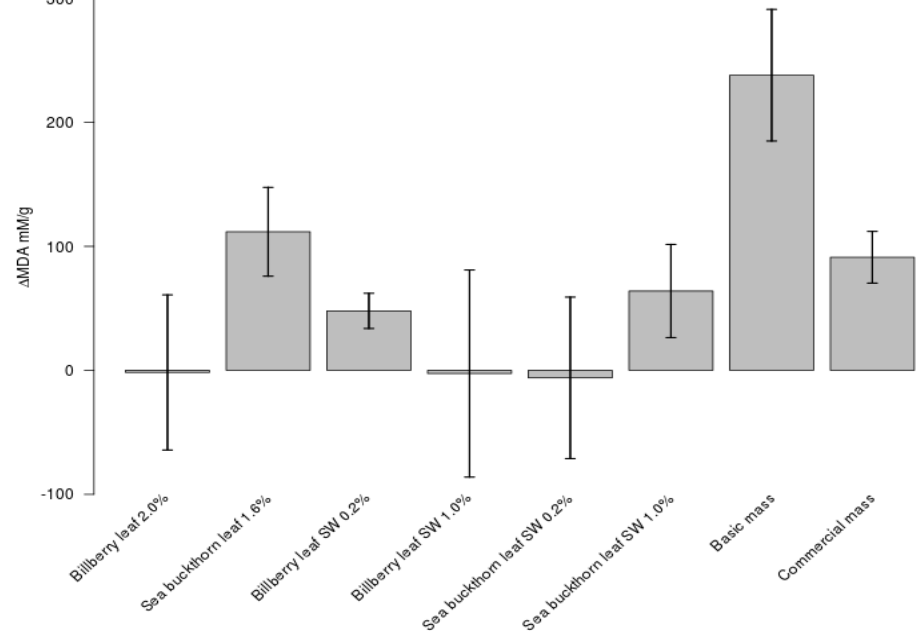
Figure 4. Effects of bilberry and sea buckthorn leaves and their SW extracts on lipid peroxidation in sausage samples during 20 days of storage.